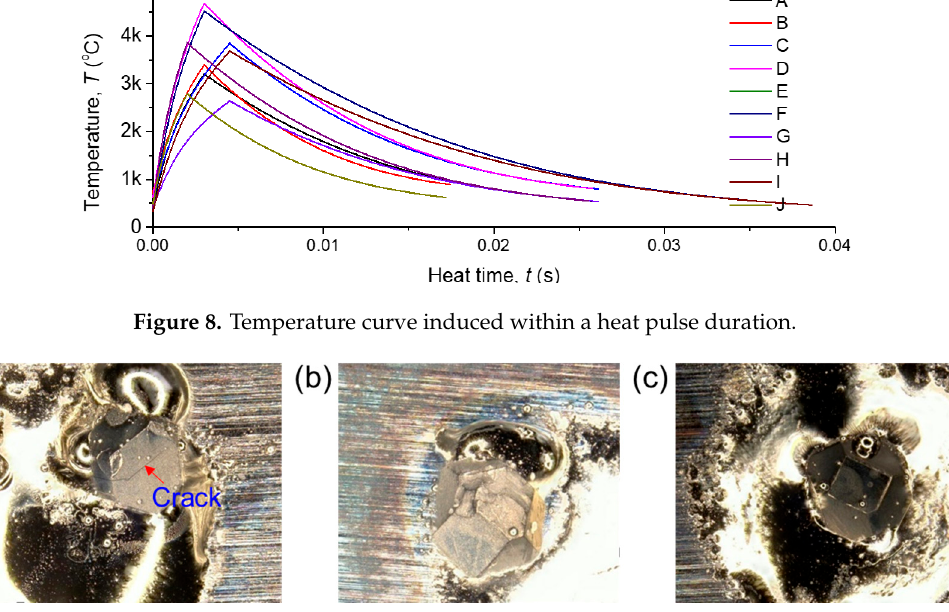
Figure 9. Diamond grains brazed by: ( a ) Case D, ( b ) Case G, and ( c ) Case E.